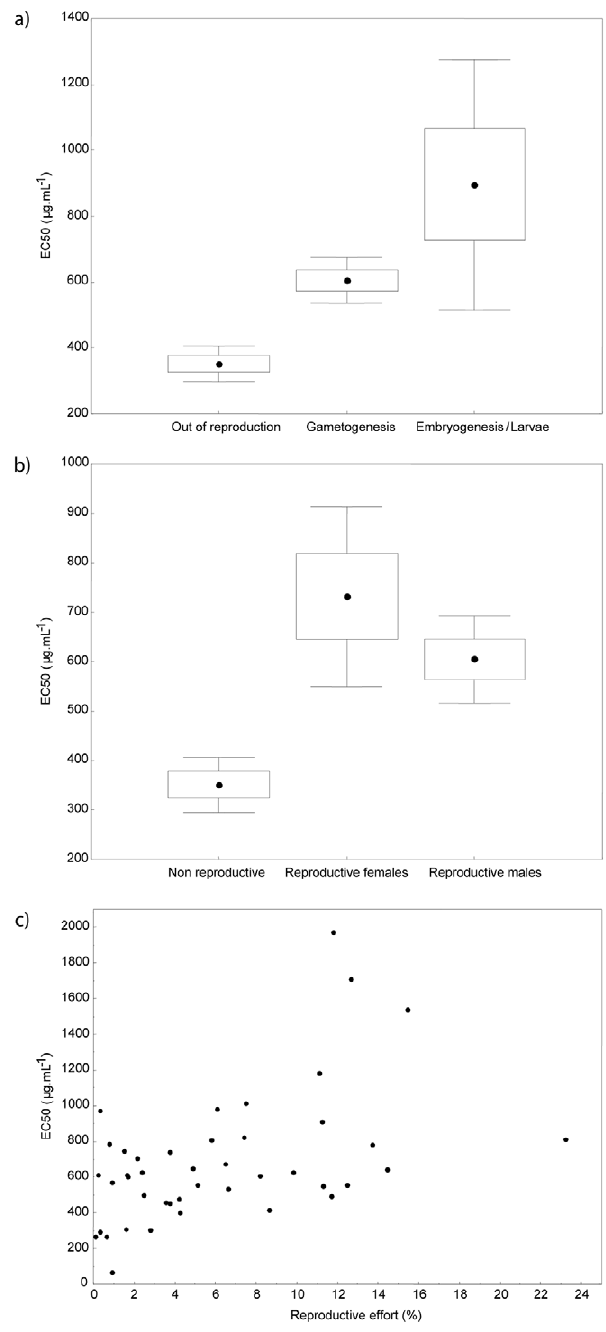
Figure 6. Influence of sponge reproductive status on the bioactivity. a) Variation of Oscarella balibaloi bioactivity (EC50 in m g.mL 2 1 ) according to reproductive stage. The effect of significance is given by Kruskal-Wallis test: H KW(2;109) = 31.48, p , 0.001. b) Variation of Oscarella balibaloi bioactivity (EC50 in m g.mL 2 1 ) according to sponge sexe. The effect of significance is given by Kruskal-Wallis test: H KW(2;109) = 31.44, p , 0.0001. c) Correlation between Oscarella balibaloi bioactivity (EC50 in m g.mL 2 1 ) and its reproductive effort (%): R=0.49, p=0.0008. Boxes represent Mean 6 0.95 SE and vertical bars Mean 6 0.95 Confidence Interval. doi:10.1371/journal.pone.0028059.g006 be species specific. Considering our extractive and analytical procedures, O. balibaloi harbors higher metabolite diversity than O. tuberculata [38], but it does not produce three of its major